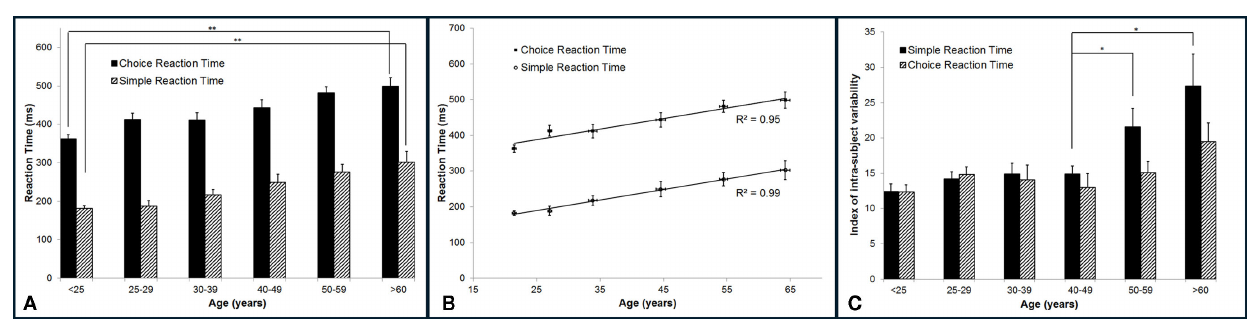
FIGURE 3 | Summary of the group-averaged RTs for six age groups. (A) Both simple and choice RT progressively increase with advancing age. Comparing the performance between the subjects under 25years to the subjects older than 60years, there is a significant difference in the mean simple RT and choice RT with p < 0.001. (B) A strong linear relationship (positive correlation) between RTs and age was observed, with R 2 = 0.99 for simple RT and R 2 = 0.95 for choice RT. (C) Summary of the